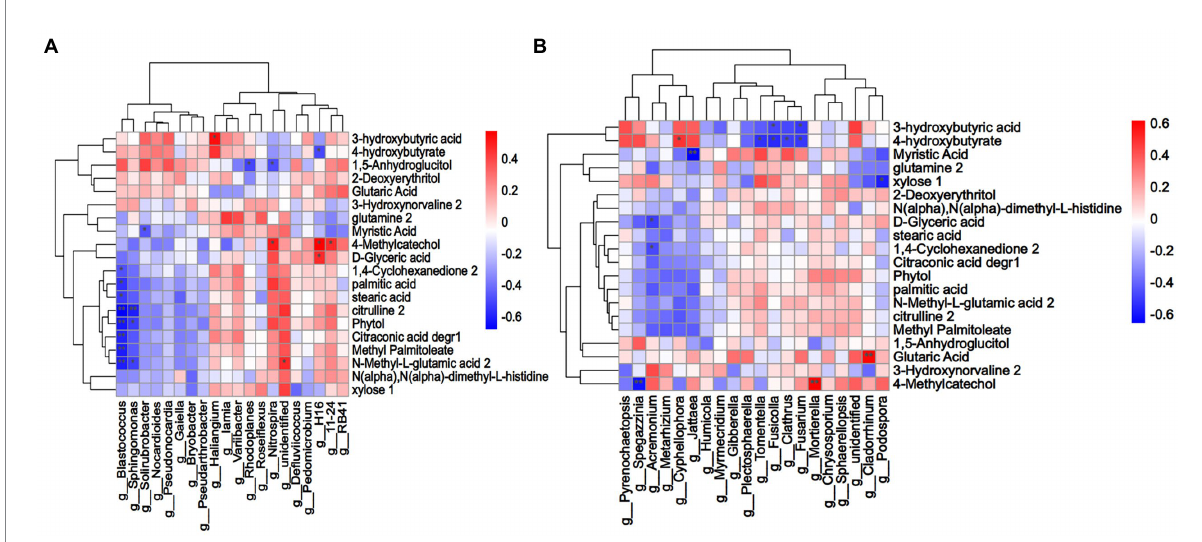
FIGURE 6 (A) Bacterial and (B) fungal Spearman correlation clustering heatmap between soil microorganisms (genus level) and differential root exudate components. Each column indicates a different microbial, and each row corresponds to the root exudate components. Red indicates a positive correlation, and blue indicates a negative correlation. A darker color indicates a greater correlation, and a lighter color indicates a lower correlation. ** p < 0.01, * p <